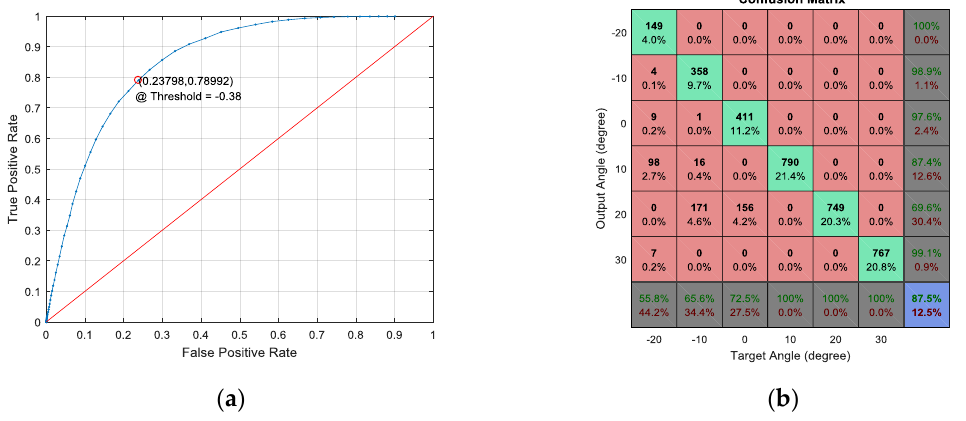
Figure 15. ( a ) The receiver operating characteristic (ROC) curve for intrinsic AoA range detection and ( b ) the confusion matrix for given discrete AoA.